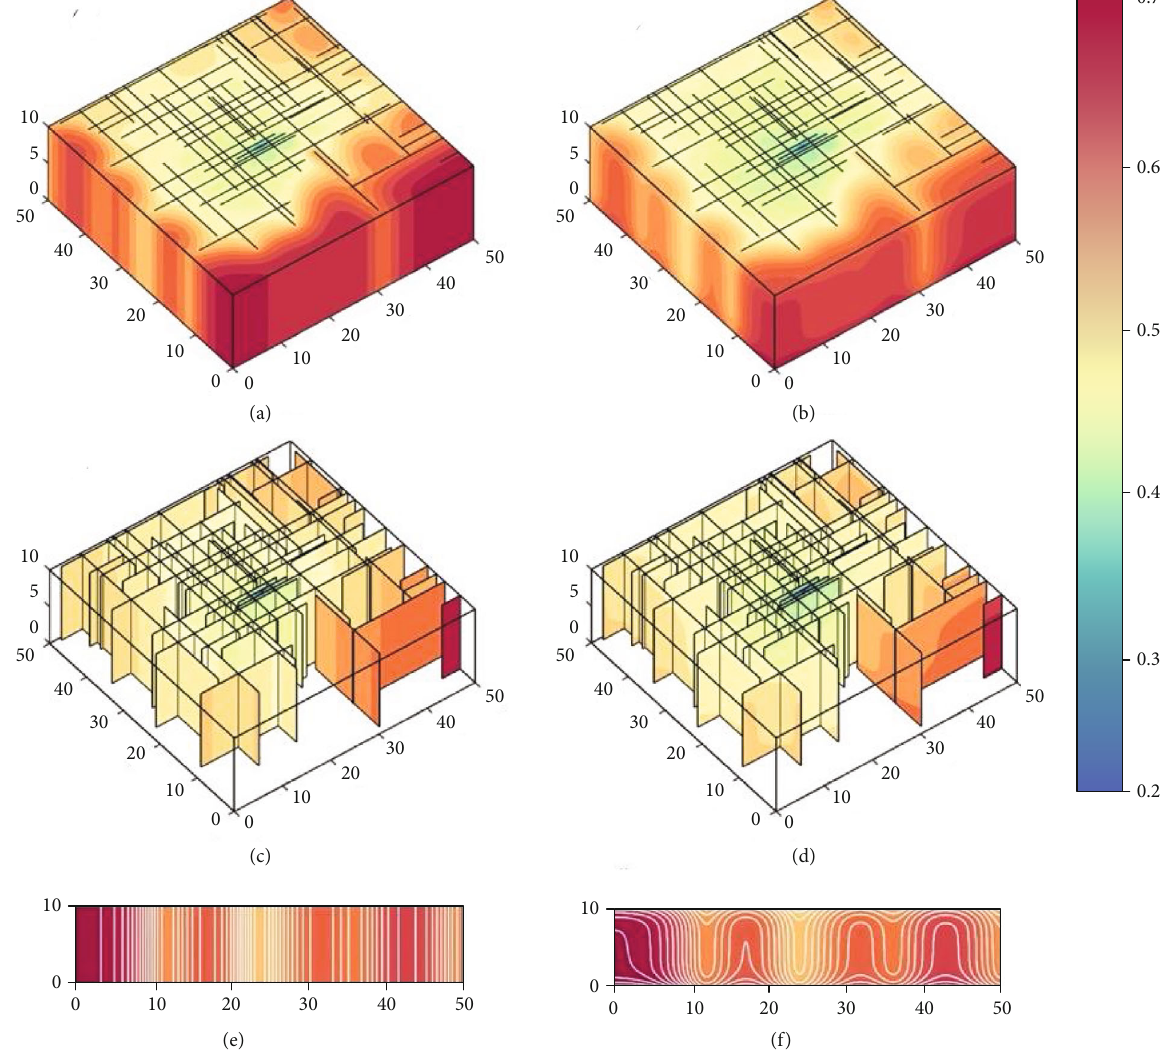
Figure 12: Water saturation after 50 days of production from the three-dimensional model with randomly distributed fractures. The results for case 2 with consideration of gravity are shown in (b), (d), and